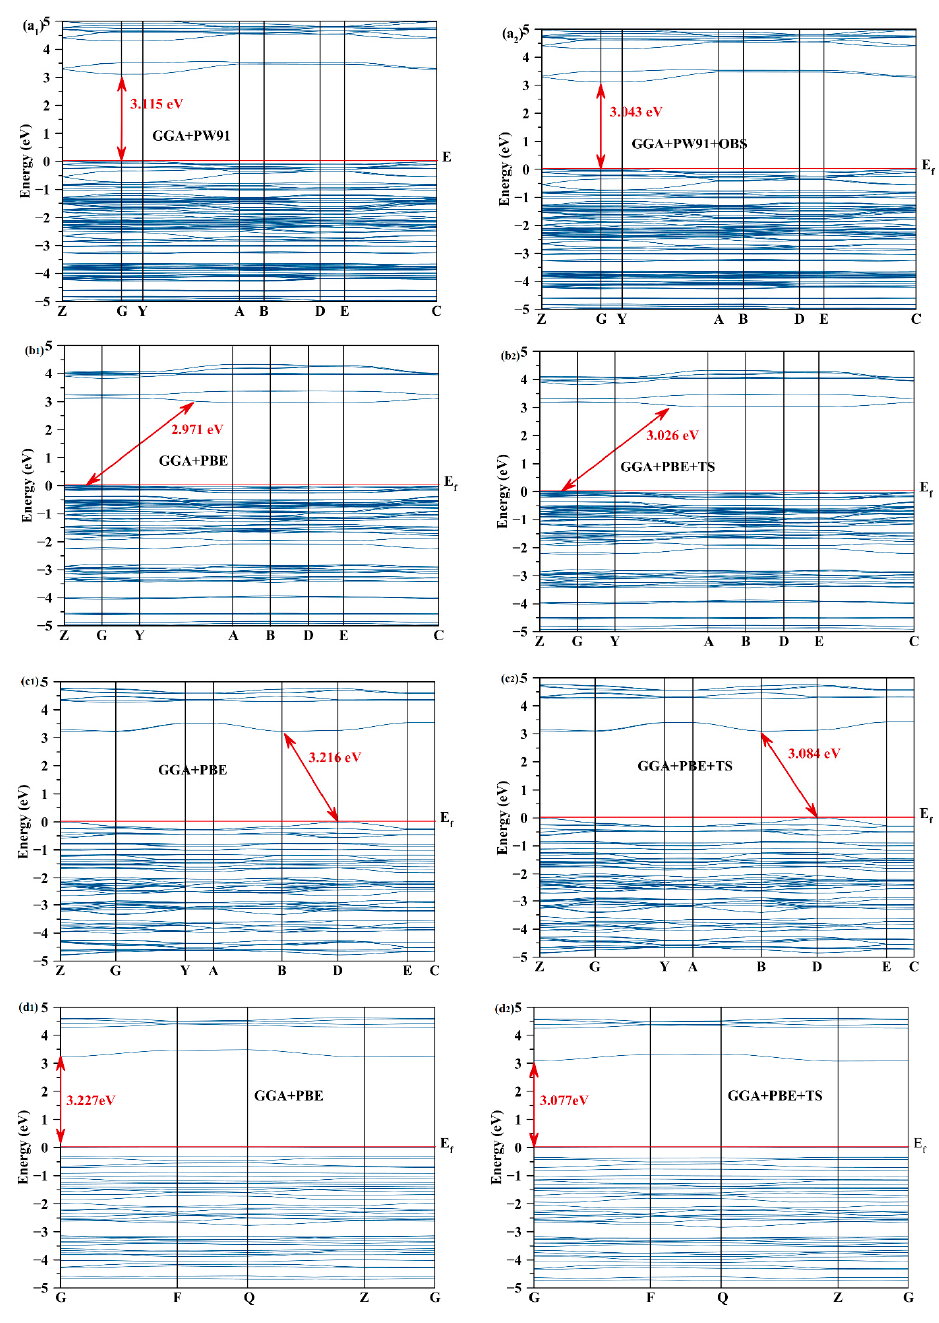
Figure 6. Electronic band structure ( a1 , a2 ) (NH 3 (CH 2 ) 2 C 6 H 5 ) 2 [SnCl 6 ], ( b1 , b2 ) (C 6 H 10 N 2 )[SnCl 6 ], ( c1 , c2 ) (C 9 H 14 N) 2 [SnCl 6 ], and ( d1 , d2 ) (C 8 H 12 N) 2 [SnCl 6 ], without dispersion interaction with index 1, and with the dispersion interaction index 2. The scheme and the approximation for each structure are indicated on the figure. Table 7. Evaluation of the structure’s similarity.